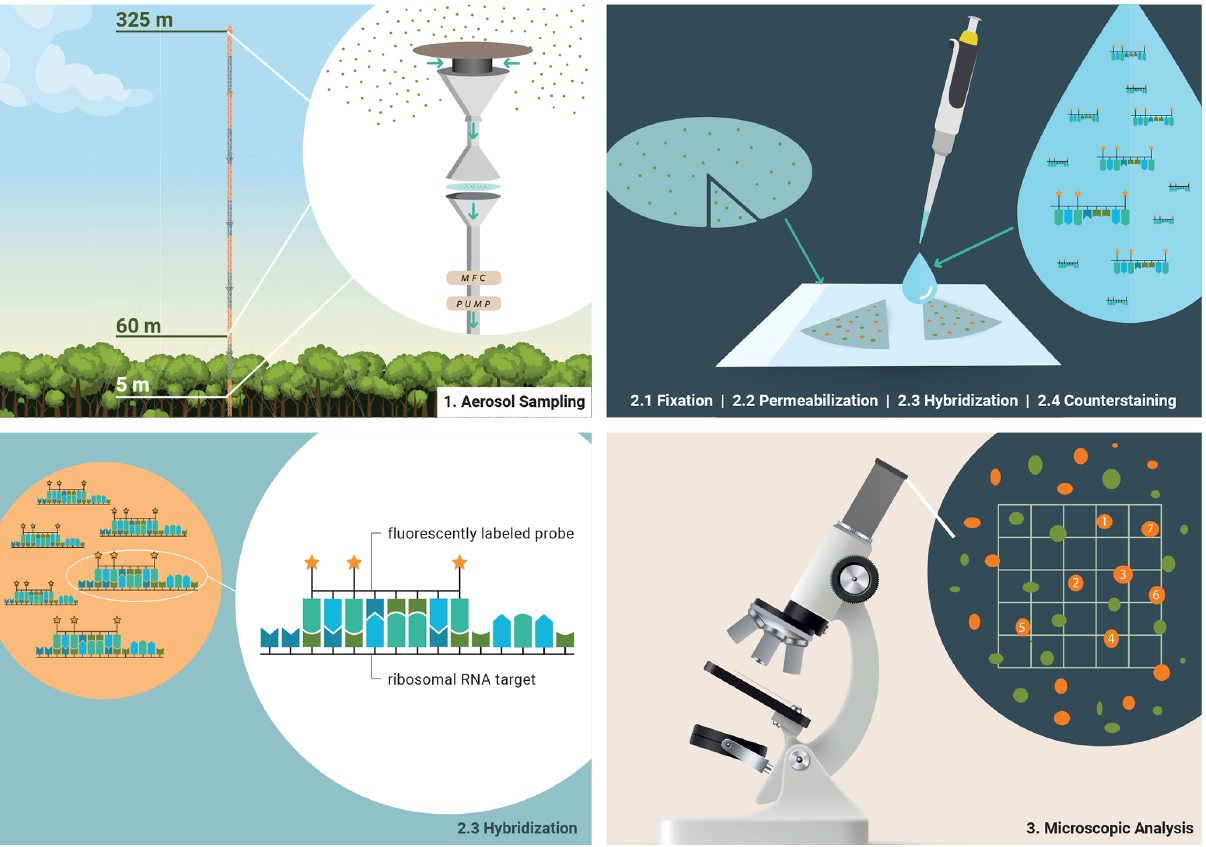
Figure 1. Bioaerosol sampling strategy in the Amazon rain forest and molecular genetic staining for microscopic identification and quantifi- cation. (1) Bioaerosols were collected on polycarbonate membranes at three different sampling heights at ATTO. (2) Biological material on the filters was prepared for staining by fixation and cell wall permeabilization. Then, fluorescently labeled oligonucleotide probes were used to assign bioaerosols at the domain level in a hybridization step. Overall bioaerosol numbers were obtained by DNA staining with DAPI, the so-called counterstaining. (3) Fluorescence signals were systematically enumerated and converted into atmospheric bioaerosol number